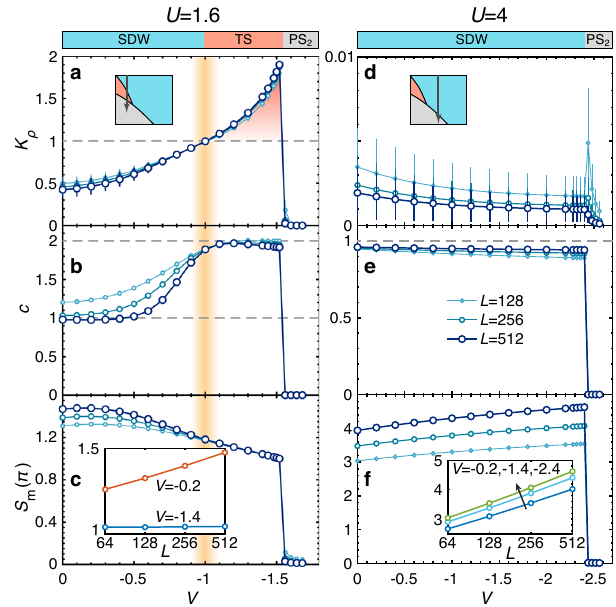
Fig. 2 Results of EHM at half fi lling. a – c are with on-site repulsion of U = 1.6 and d – f of U = 4, with the corresponding mini phase diagrams also depicted. a , d show the results of the Luttinger parameter K ρ , ( b , e ) are the results of central charge c determined from the entanglement entropy scalings, and c , f are the spin structure factors at π . Here the K ρ results in a , d are obtained via the second-order polynomial fi tting of S c ( k ) in the small- k regime, with the error bars estimated by using different k -range for fi tting (Supplementary Note 3). The insets in c , f show S V s. a – c reveal the system undergoes a transition from spin density wave (SDW) to triplet superconducting (TS) phase at V c ≃ − 1 and then enters the phase separation (PS 2 ) regime for V < V s ≃ − 1.55. d – f show no intermediate phase but a direct fi rst-order transition from SDW to PS 2 at V ≃ − s